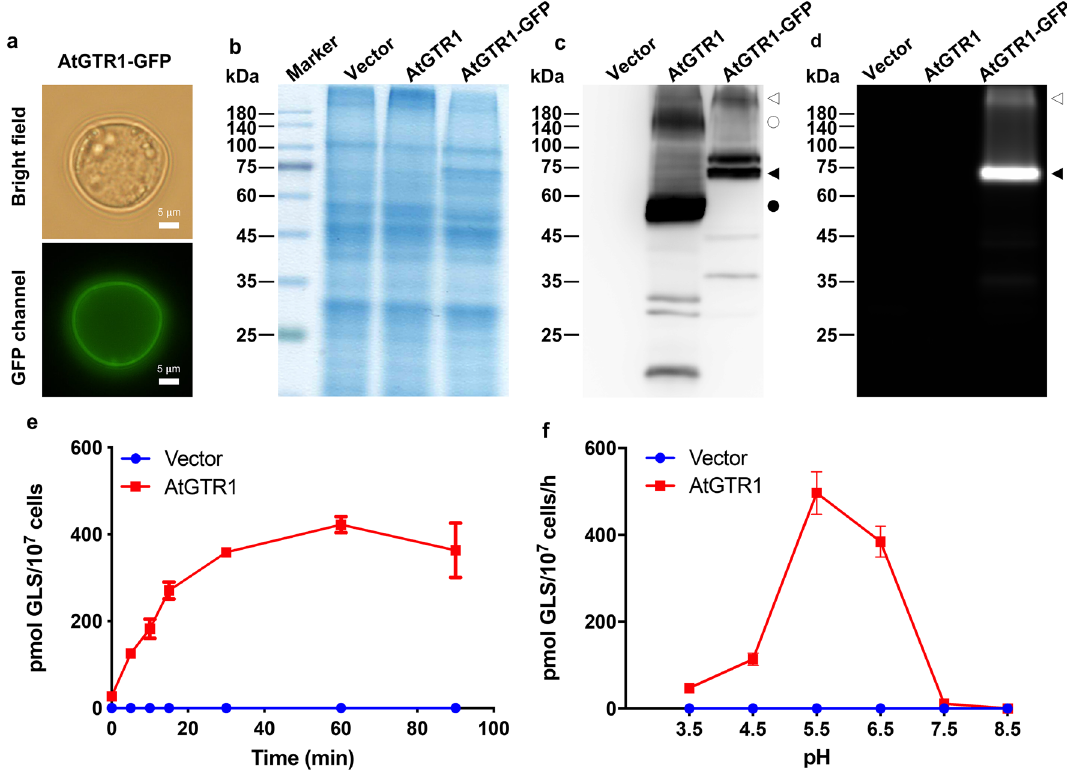
Figure 1. Yeast-expressed AtGTR1 localized to the cell membrane and showed the GLS transport activities. ( a ) Microscopic observation of AtGTR1-GFP-expressing yeast cells. The scale bar represents 5 μm. ( b–d ) The yeast membrane fractions isolated from AtGTR1-GFP-expressing and AtGTR1-expressing yeasts were analyzed by ( b ) SDS-PAGE, ( c ) western blotting, and ( d ) in-gel fluorescence. The primary antibody is an anti-His-tag antibody. The filled triangle and filled circle indicate the predicted positions of the AtGTR1-GFP and AtGTR1 bands, respectively. The open triangle and open circle indicate the predicted positions of dimeric AtGTR1-GFP and AtGTR1 bands, respectively. ( e ) Time-dependent GLS accumulation via AtGTR1. Yeast cells expressing AtGTR1 were incubated with 100 μM GTR for different lengths of time, and then GLS contents of the yeasts were quantified by RP-HPLC. ( f ) pH profile of the GLS transport of AtGTR1. Yeast cells were incubated in the assay medium containing 100 μM GTR with various pH for 1 h and then lysed to quantify the GLS contents by RP-HPLC. All data points with error bars represented the mean ± SD of three independent